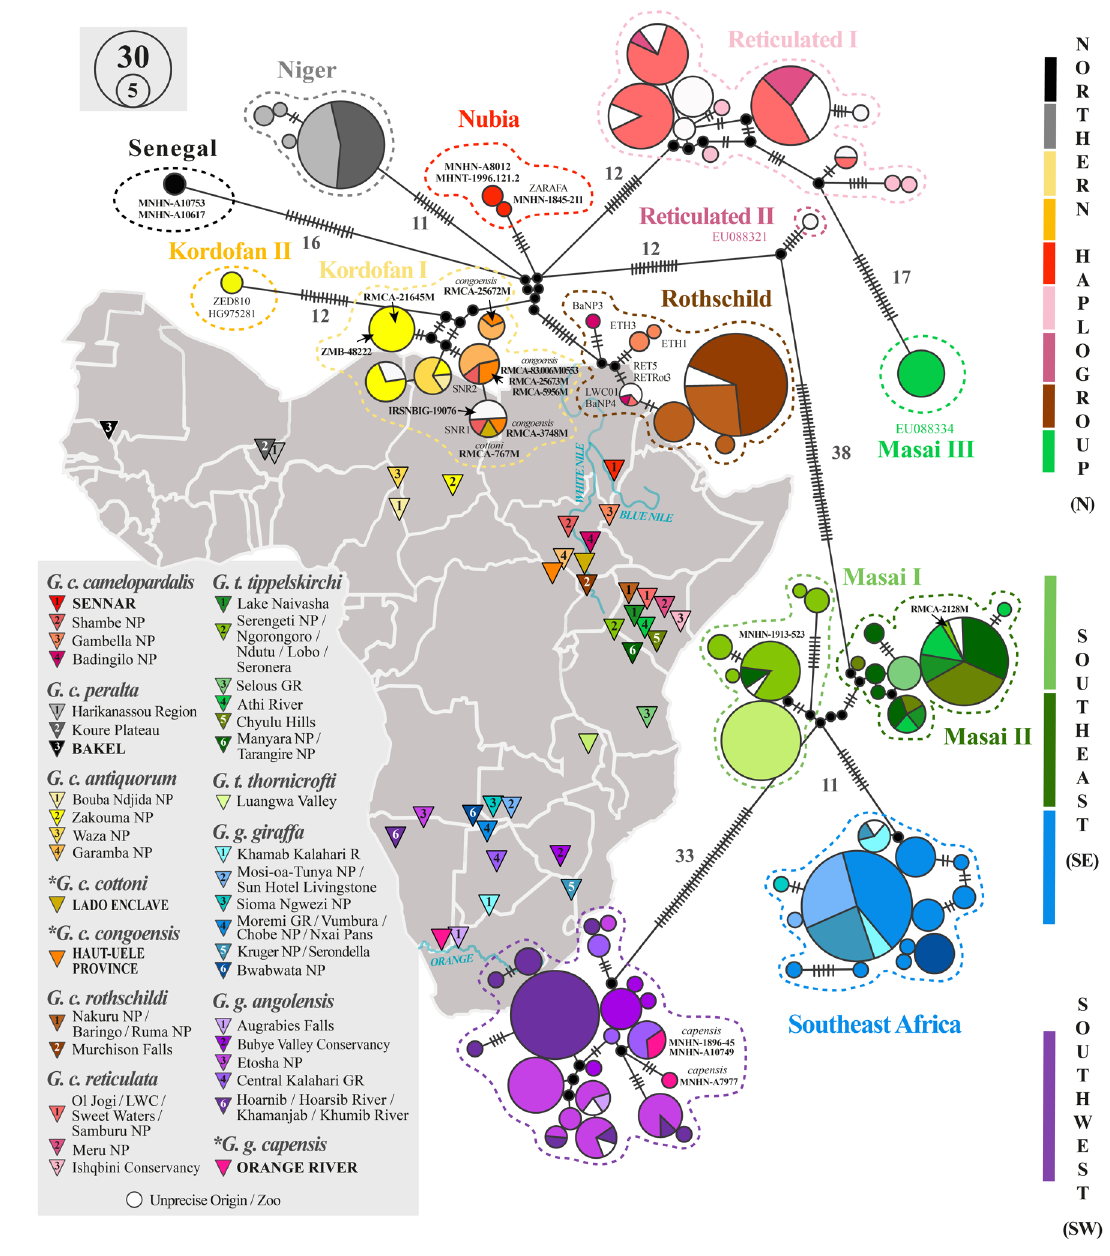
Fig. 3. Median-joining network of mitochondrial haplotypes. The network was constructed in PopART 1.7 (Leigh & Bryant 2015) based on the mitochondrial sequences of 548 giraffes. The number of mutations between haplotypes is indicated by perpendicular lines on the branches and is specified if greater than 10. The size of the circles is proportional to the number of individuals sharing a certain haplotype with colours assigned by subspecies. The sample locations are indicated by triangles in the map and highlighted in bold capital letters for museum specimens. The subspecies marked with an asterisk represent formerly recognized subspecies, which were synonymized in recent classifications (e.g., Shorrocks 2016). Historical key specimens are highlighted by the respective abbreviation of the museum and the catalogue